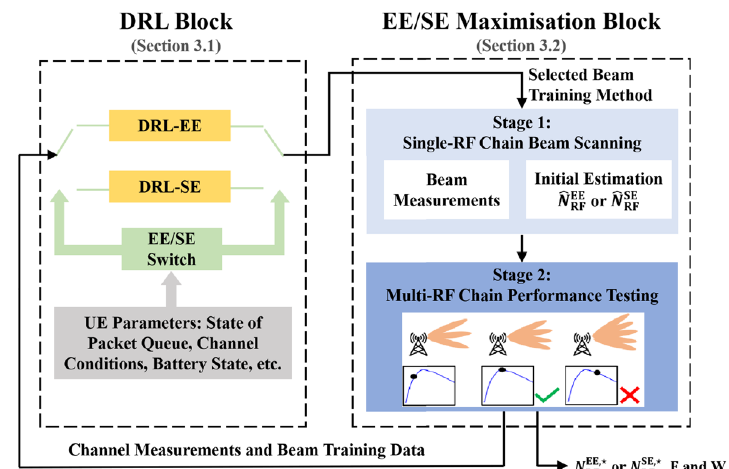
Fig. 3 The block diagram of the proposed DRL-based beam training